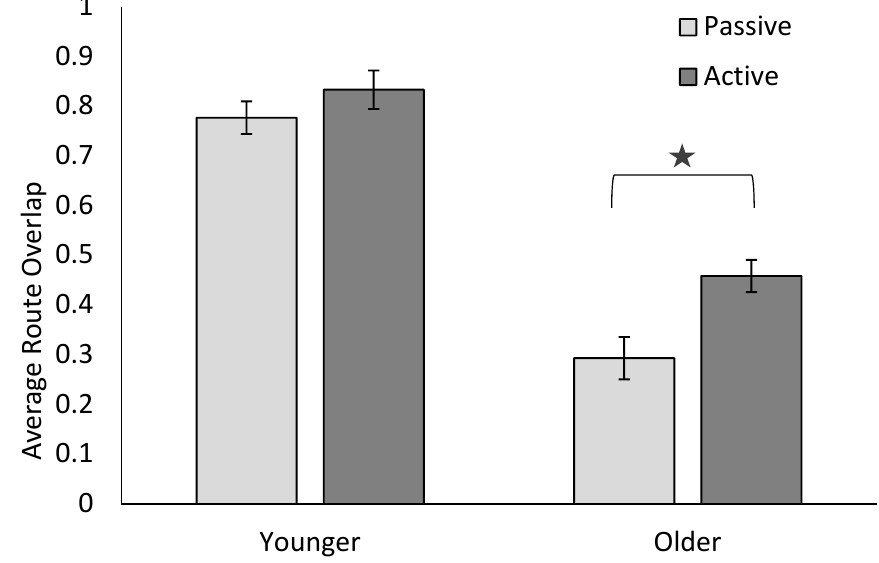
Figure 3. Average percent Route Overlap values for active and passive encoding in younger and older adults. Error bars represent the standard error. The star represents significant differences between active and passive conditions for older adults.